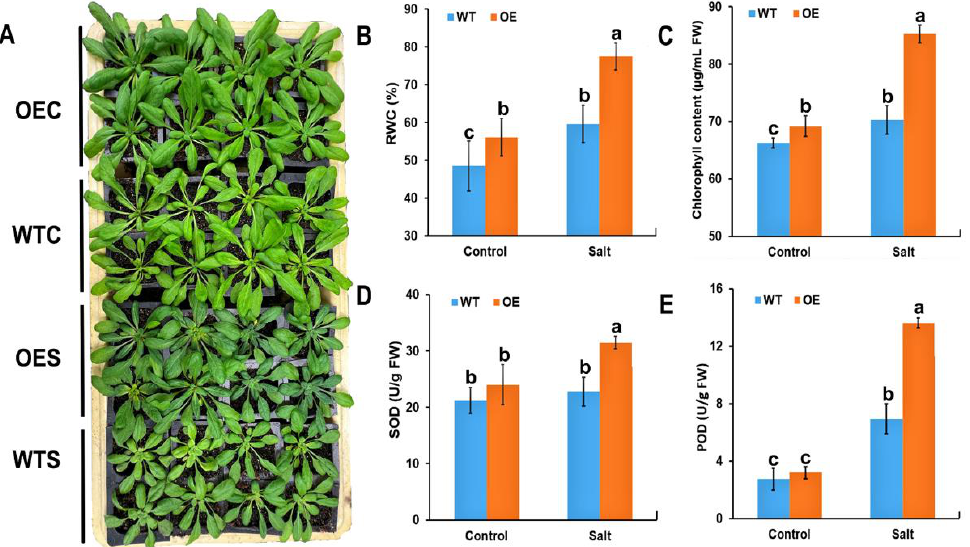
Figure 3. Phenotype and physiological characteristics of the OE and WT plants under control and salt stress conditions. ( A ) Phenotypes of OE and WT under control and salt stress conditions. OEC, McHB7 -OE Arabidopsis irrigated with water. WTC, wild-type Arabidopsis irrigated with water. OES, McHB7 -OE Arabidopsis treated with 200 mM NaCl for seven days. WTS, wild-type Arabidop- sis treated with 200 mM NaCl for seven days. ( B ) RWC of OE and WT under control and salt stress conditions. ( C ) Chlorophyll content. ( D ) SOD activity. ( E ) POD activity. Error bars indicate mean ± SD ( n = 4). Means denoted by the same letter did not significantly differ at p < 0.05, according to Duncan’s multiple range test.